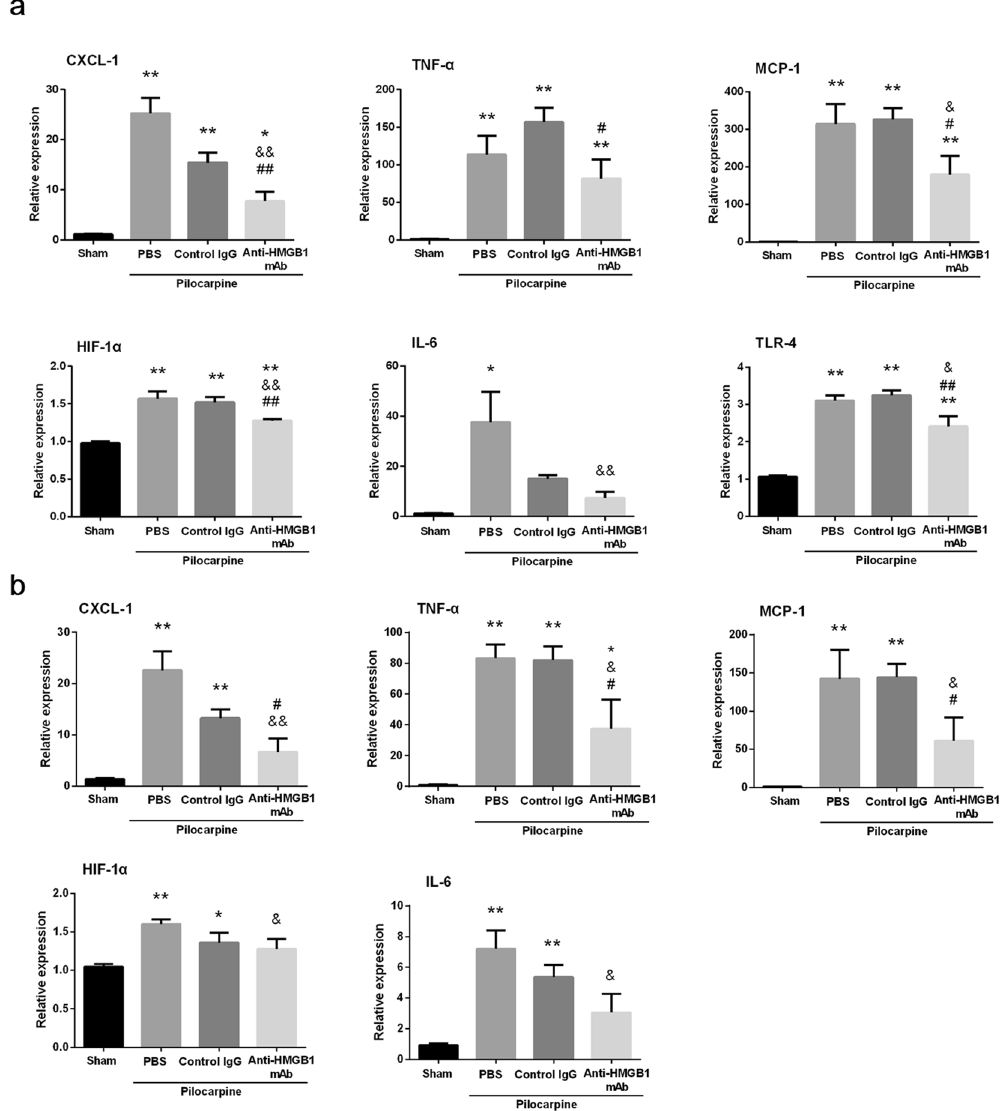
Figure 7. Determination of the expression of inflammation-related molecules by quantitative real-time PCR in the hippocampus ( a ) and cerebral cortex ( b ) in mice with pilocarpine-induced acute status epilepticus. Anti-HMGB1, control IgG or PBS was administered intravenously when mice reached Racine stage 5 after pilocarpine. Brain samples were collected 24 h after antibody administration. The results were normalized to the expression of GAPDH and are expressed as the means ± SEM of 11 mice. * p < 0.05, ** p < 0.01 compared with the sham group. & p < 0.05, && P < 0.01 compared with the PBS control. # p < 0.05, ## p < 0.01 compared with the control IgG group ( a , b